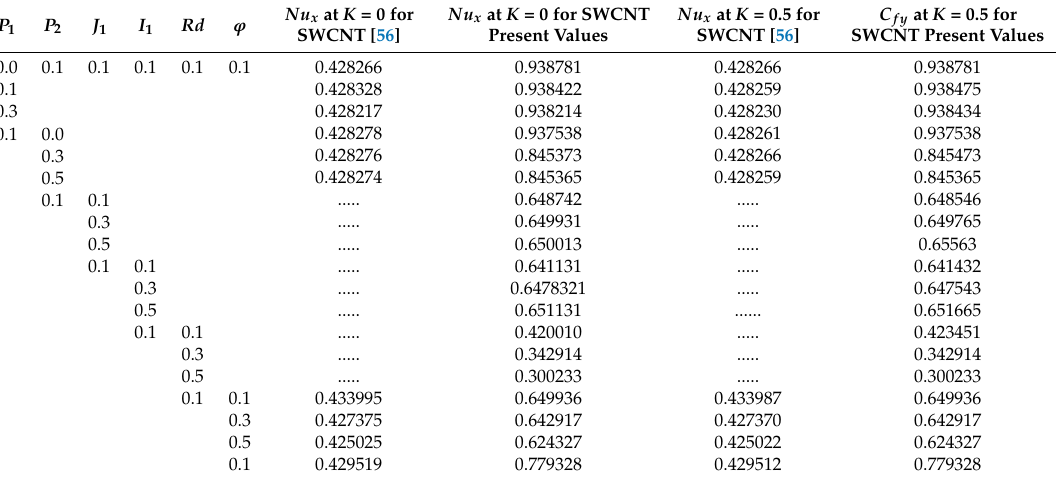
Table 7. Variation in the Nusselt numbers Nu x for SWCNTs together with strong and weak concentrations K = 0 and K = 0.5 and the comparison with previous results for E r = 0.3, δ = 0.2, and Re =